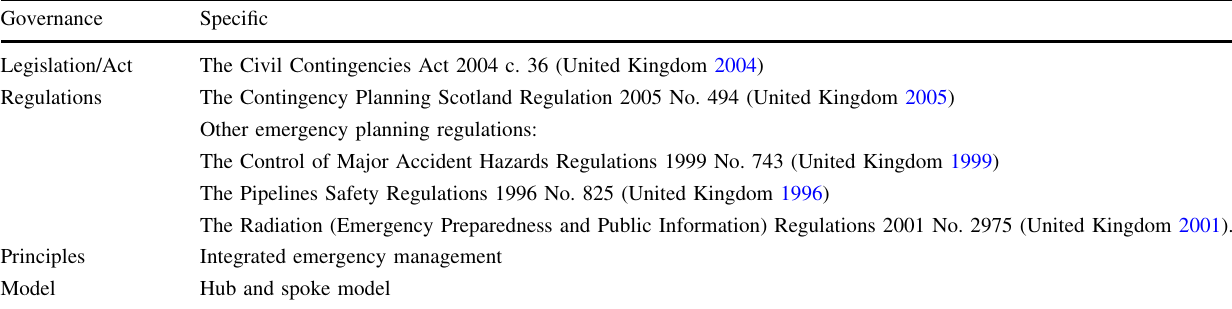
Table 2 The legal governance of community resilience in Scotland. Source: Adapted from the Preparing Scotland report (Scottish Government 2019a)